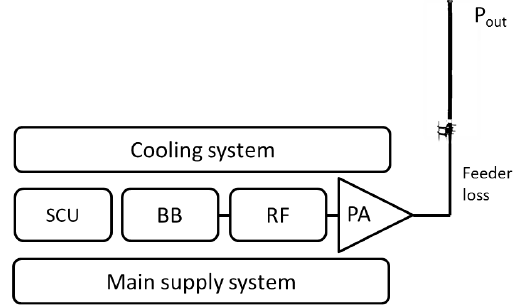
Figure 6. TETRA base station